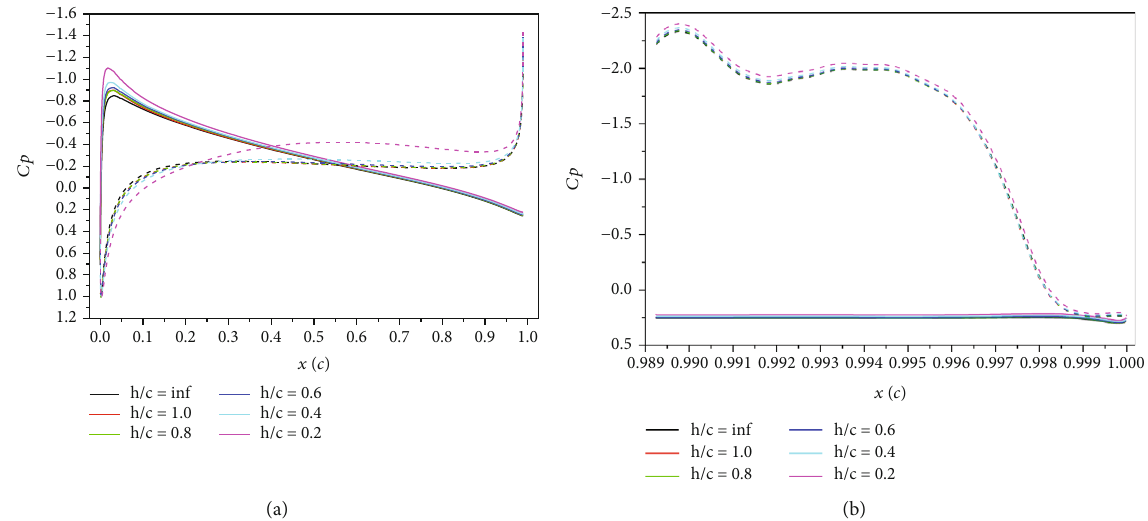
= − 0 : 013 at α = 4 ° : (a) pressure coe ffi cient of the main airfoil; (b) μ